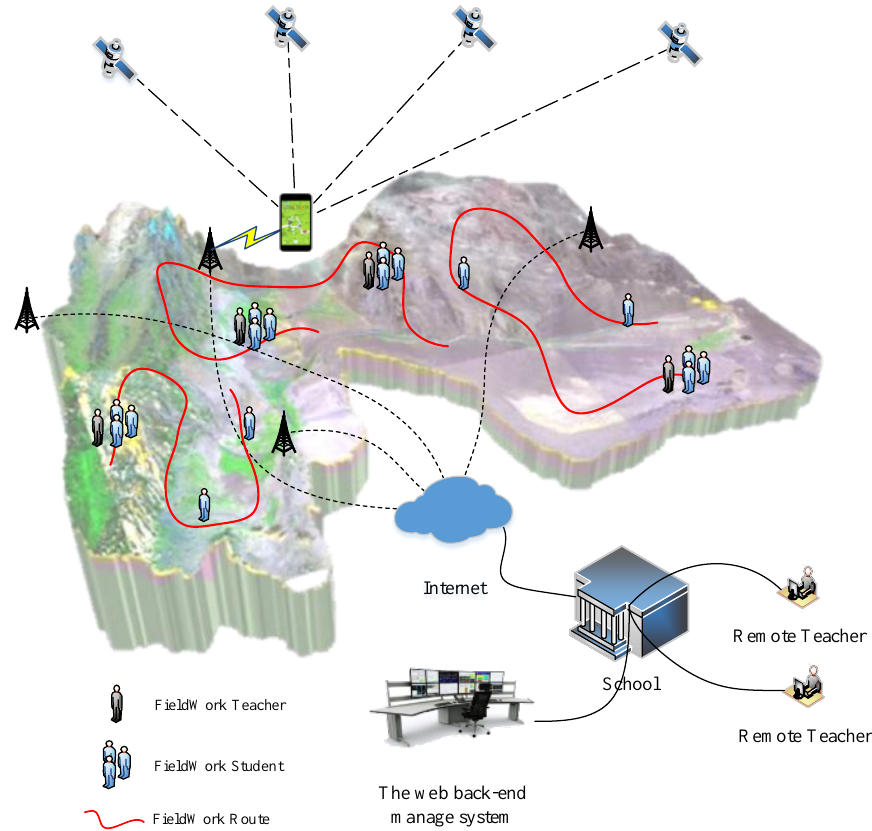
Figure 4. The application of remote guidance and safety supervision based on the platform for students during the fieldwork.